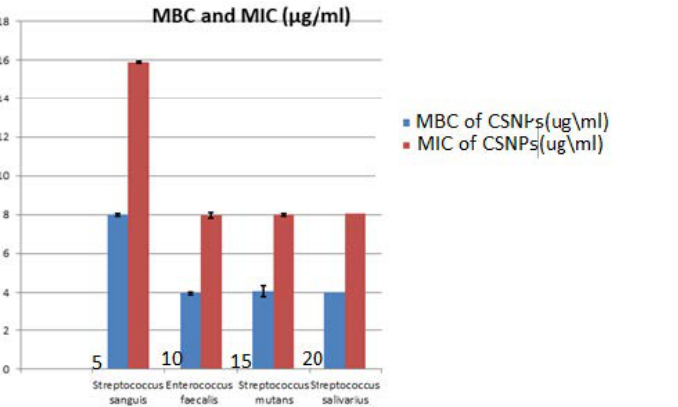
Figure 11. Minimum Inhibitory Concentration (MIC) and Minimum Bacterial Concentration (MBC). of chitosan nanoparticles (CSNPs) against Streptococcus sanguis , Enterococcus faecalis , Streptococcus mutans , and Streptococcus salivarius . Table 3. Minimum Inhibitory Concentration (MIC) and Minimum Bacterial Concentration (MBC) of HAPNPs.